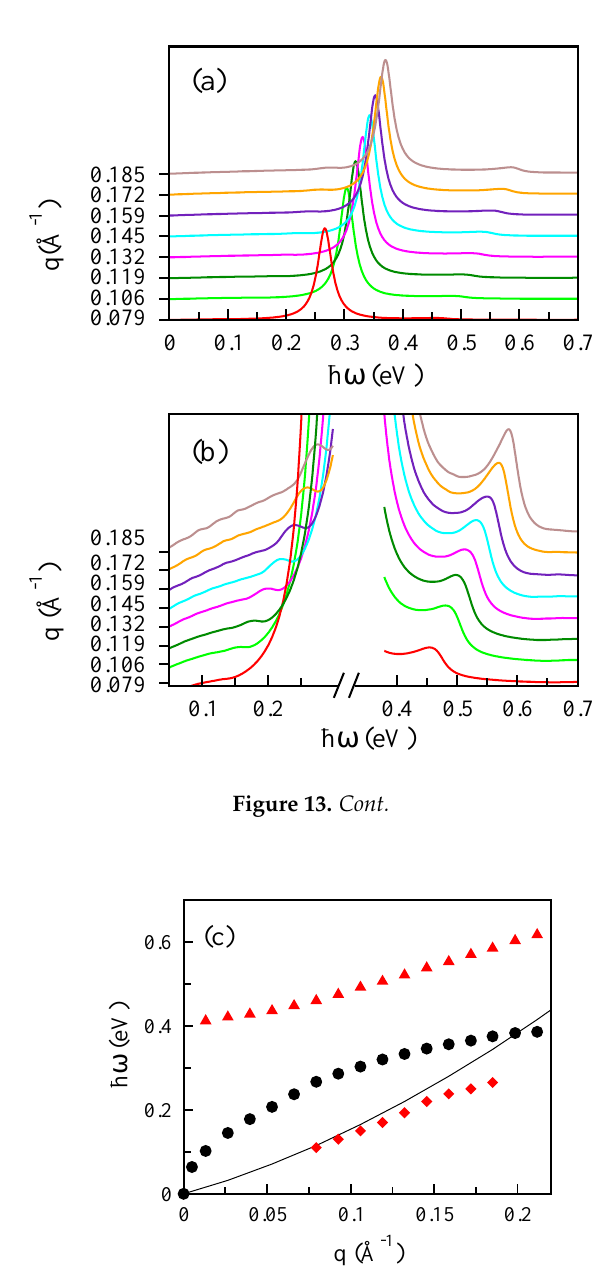
Figure 13. ( a ) The loss spectra of bilayer MoS 2 for various amounts of q along the Γ − K direction with E F = 0.05 eV corresponding to n = 6.9 × 10 13 cm − 2 . ( b ) The same as (a) for two different energy regions. ( c ) Three different plasmon modes of bilayer MoS 2 ; the black dots refer to the optical plasmon mode. The results of the acoustic and high energy modes are shown by red diamond and triangle symbols, respectively. The black line shows the boundary of the electron-hole